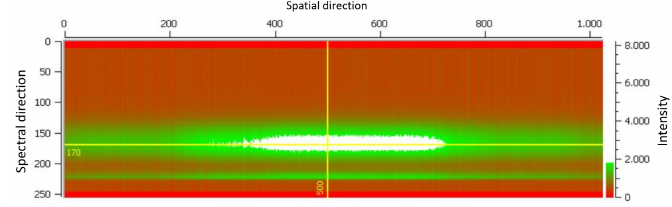
Figure 11. Image on DESIS of white LED